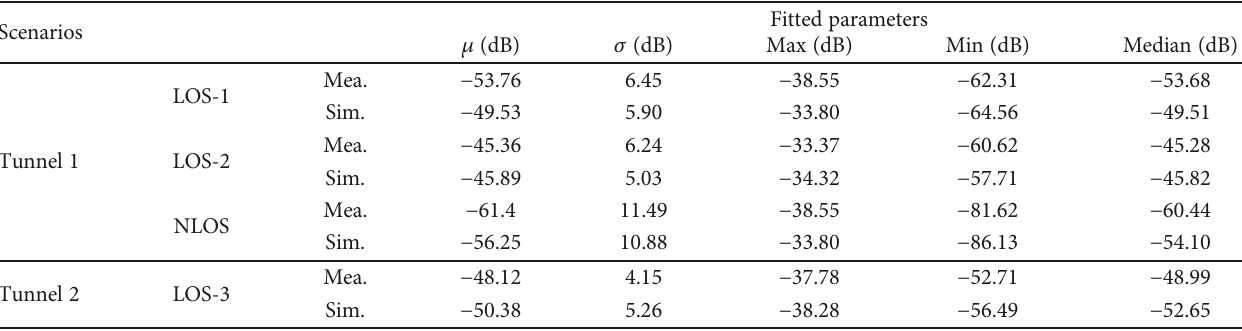
Table 3: Received power values for all